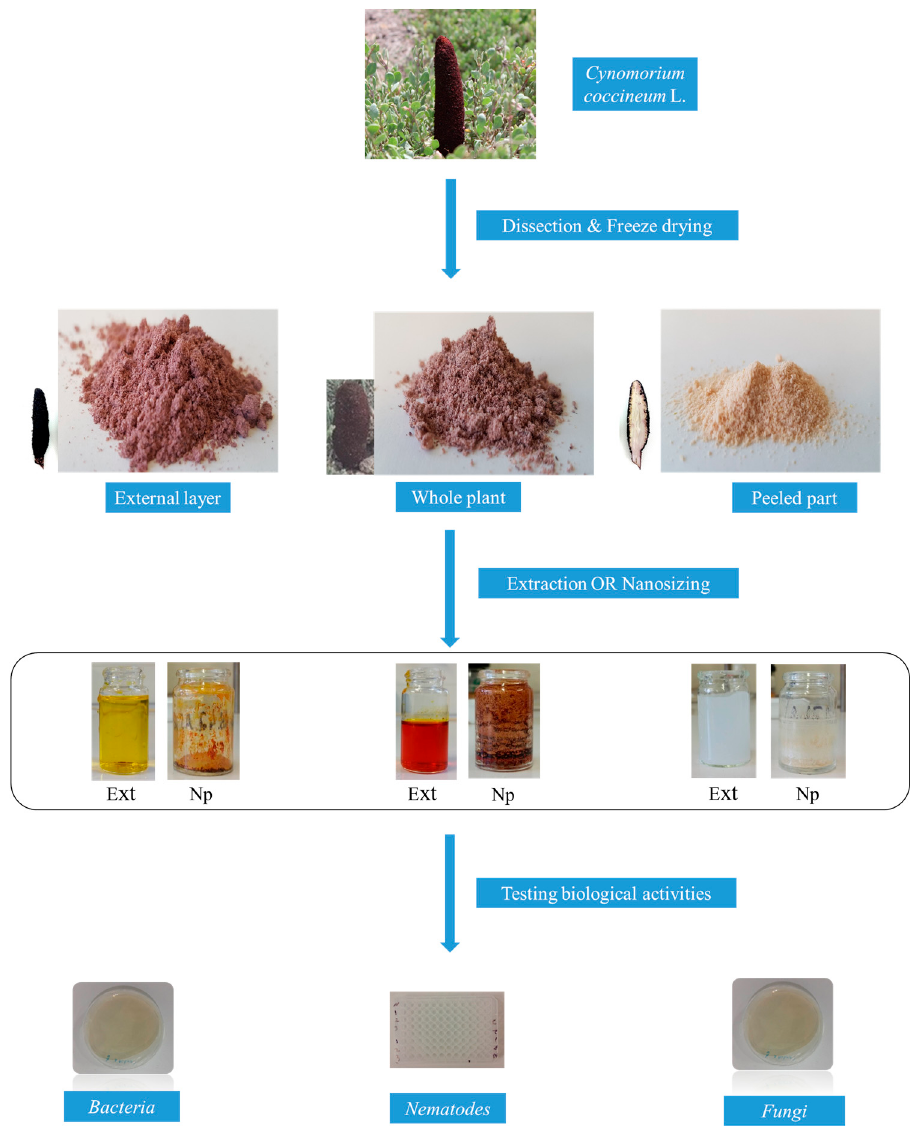
Figure 2. A Schematic overview of the different steps of sample preparation, including dissection, freeze drying, extraction/nanosizing and subsequent biological evaluation. See text for details. Extract (Ext); Nanoparticles (Np).